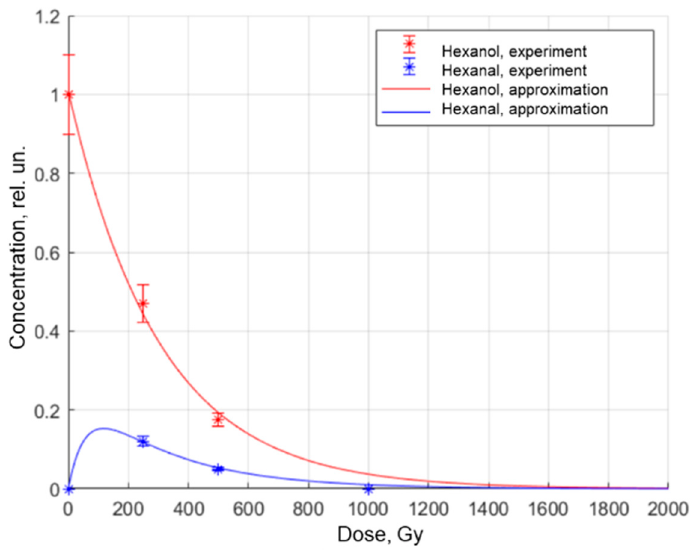
Figure 3. The dependencies of the concentrations of hexanol and hexanal on the irradiation dose obtained in the solution of hexanol alcohol.